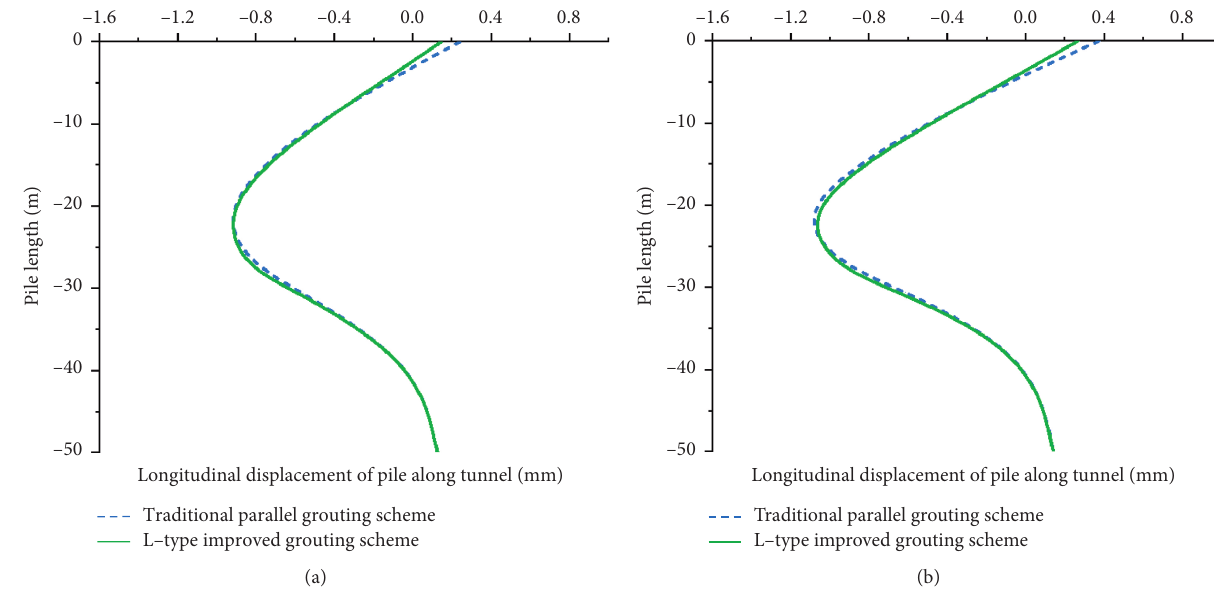
Figure 21: Longitudinal displacement of the pile along tunnel: (a) 6 rings before arriving at the pile; (b) 4 rings before arriving at the pile.